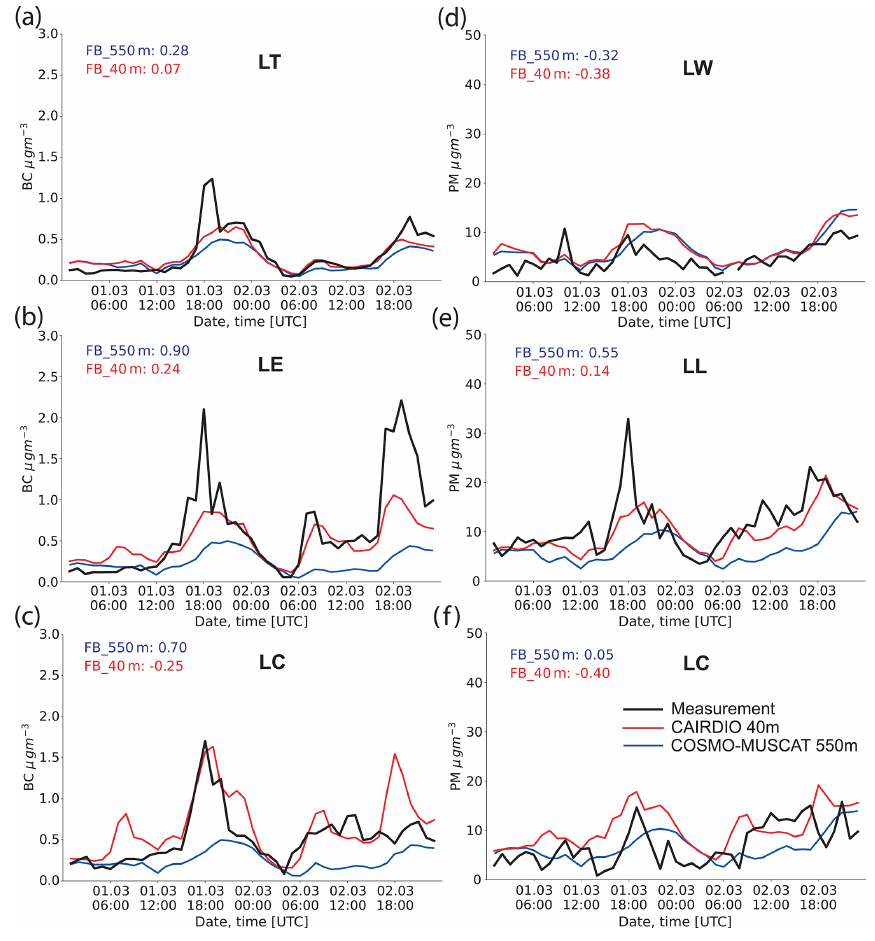
Figure 15. Comparison of measured BC concentrations (black lines) at the sites LE (a) , LC (b) , and LT (c) with simulation results of CAIRDIO L0 (red lines) and COSMO-MUSCAT M3 (blue lines). Respective profiles for PM 10 are shown for the sites LL (d) , LC (e) , and LW (f) . Additionally shown are temporally averaged fractional bias (FB) values in relation to measurements for all model